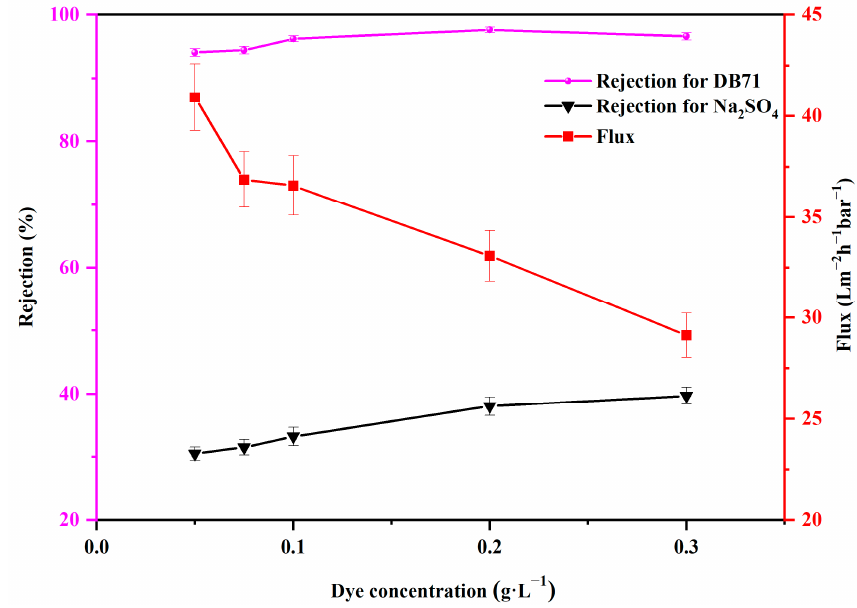
Figure 14. The e ff ect of DB71 concentrations (0.05~0.30 g·L − 1 ) with 2 g·L − 1 Na 2 SO 4 solution on PES–DPS–1 separation performance.